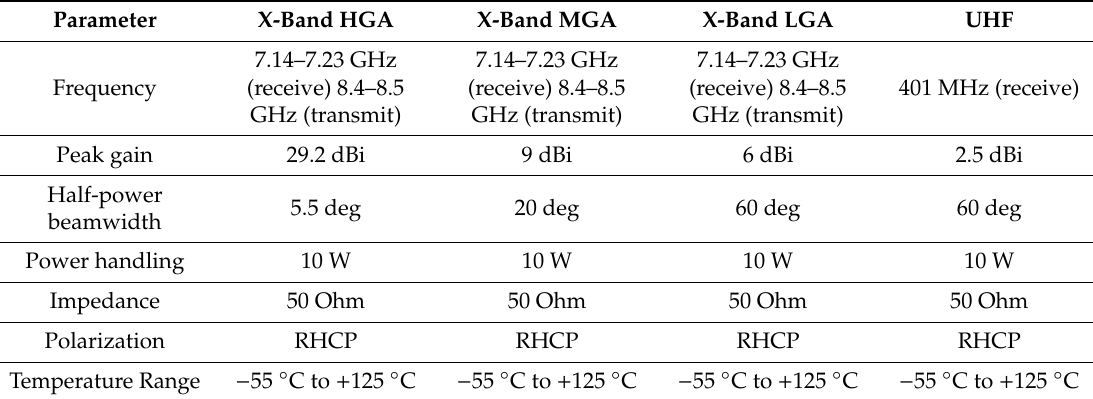
Figure 7. MarCO HGA mounted on spacecraft [7]. Table 2. MarCO’s antennas characteristics.